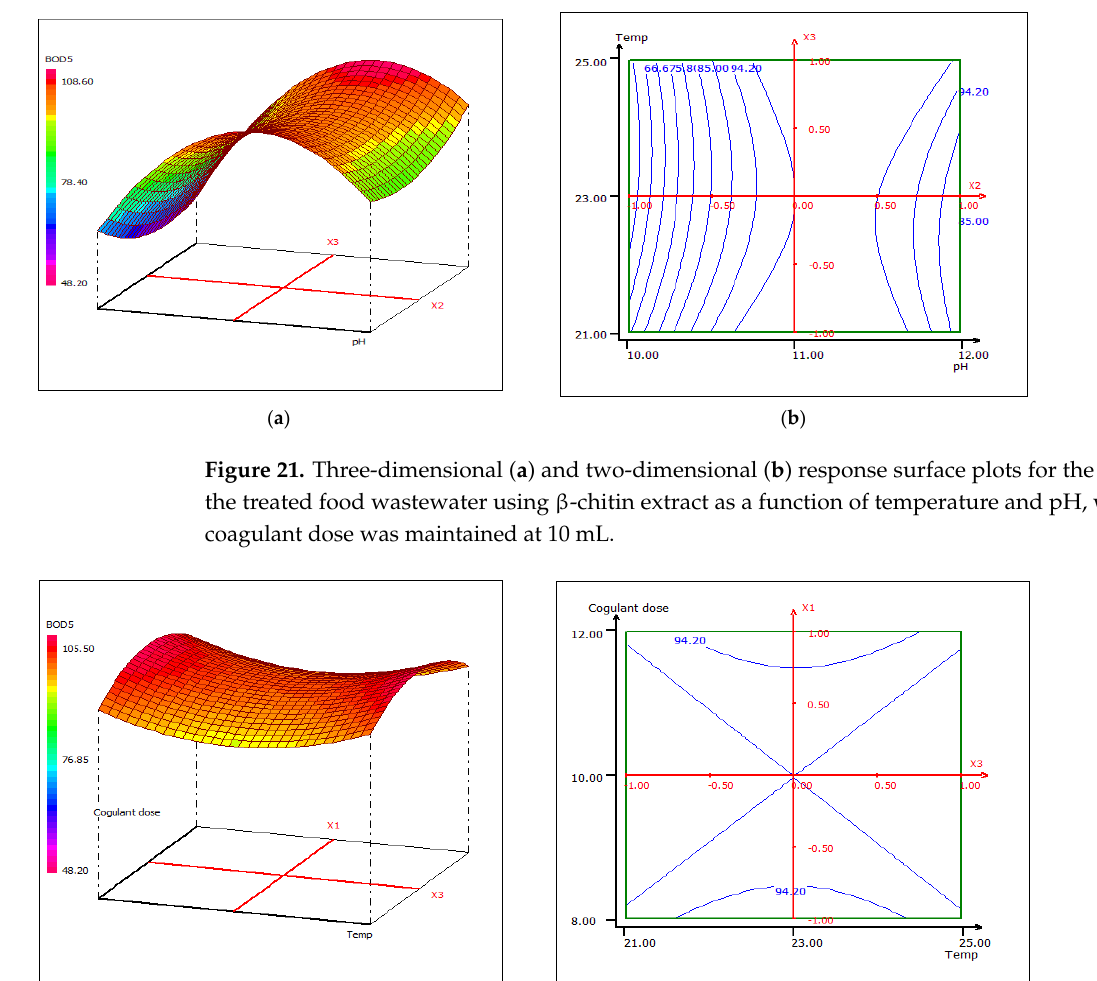
Figure 20. Three-dimensional ( a ) and two-dimensional ( b ) response surface plots for the BOD 5 of the treated food wastewater using β-chitin extract as a function of coagulant dose and pH, when the temperature was maintained at 23°C.